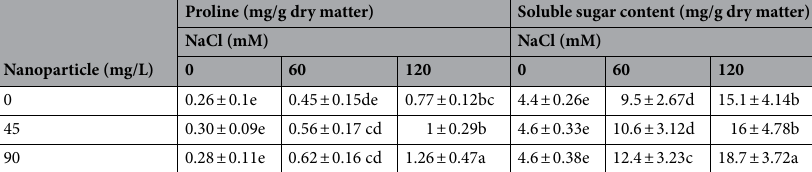
Nanoparticle (mg/L)